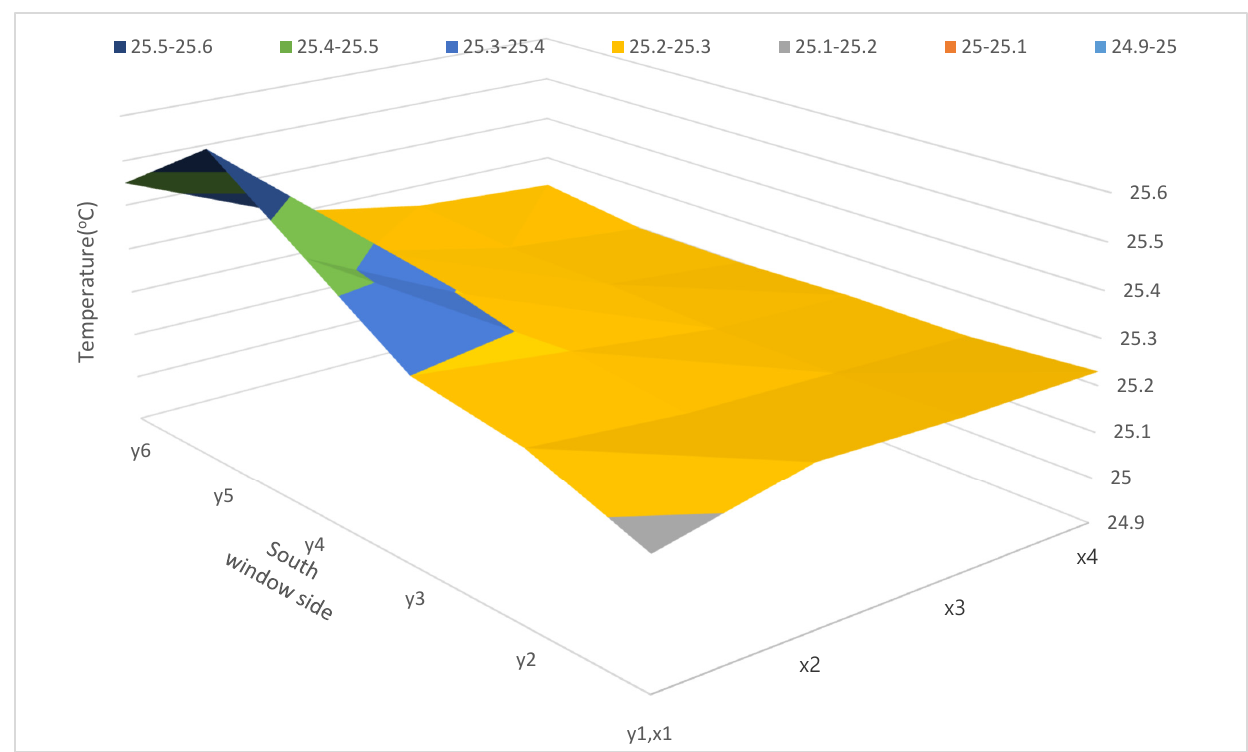
Figure 8. MRT distribution for the radiant floor cooling system for the house (7 August, p.m. 12:51; Outdoor air temperature: 36.1 °C).